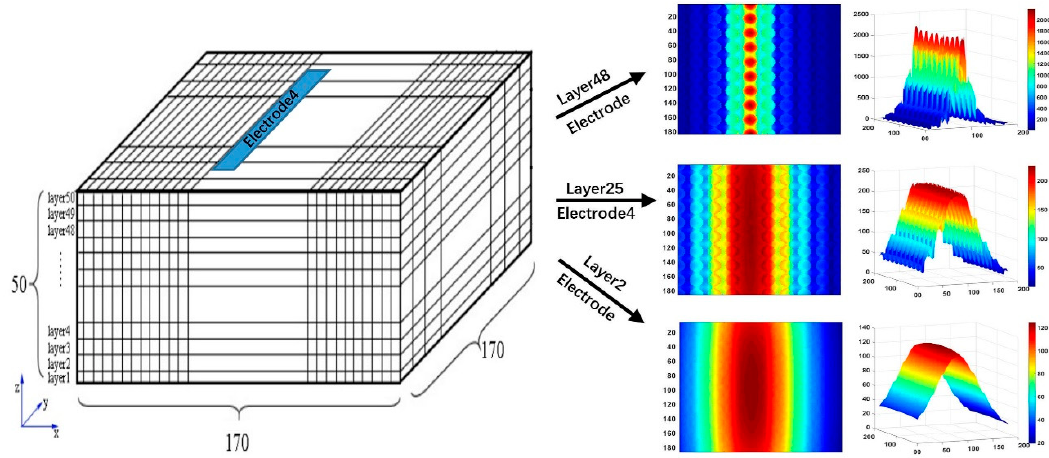
Figure 5. Sensitivity distribution at different z directional layers while capacitance array is placed vertically.